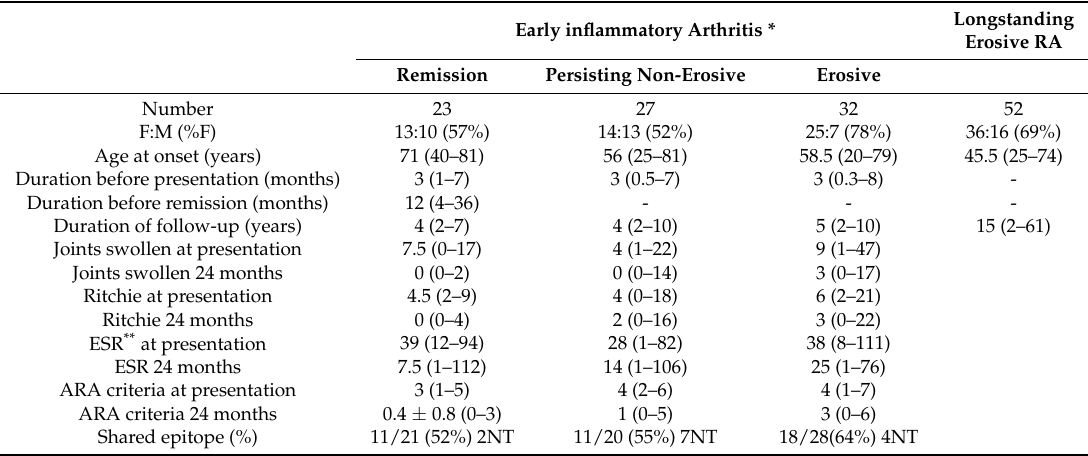
Table 1. Patients with arthritis grouped according to outcome. Results are shown as median